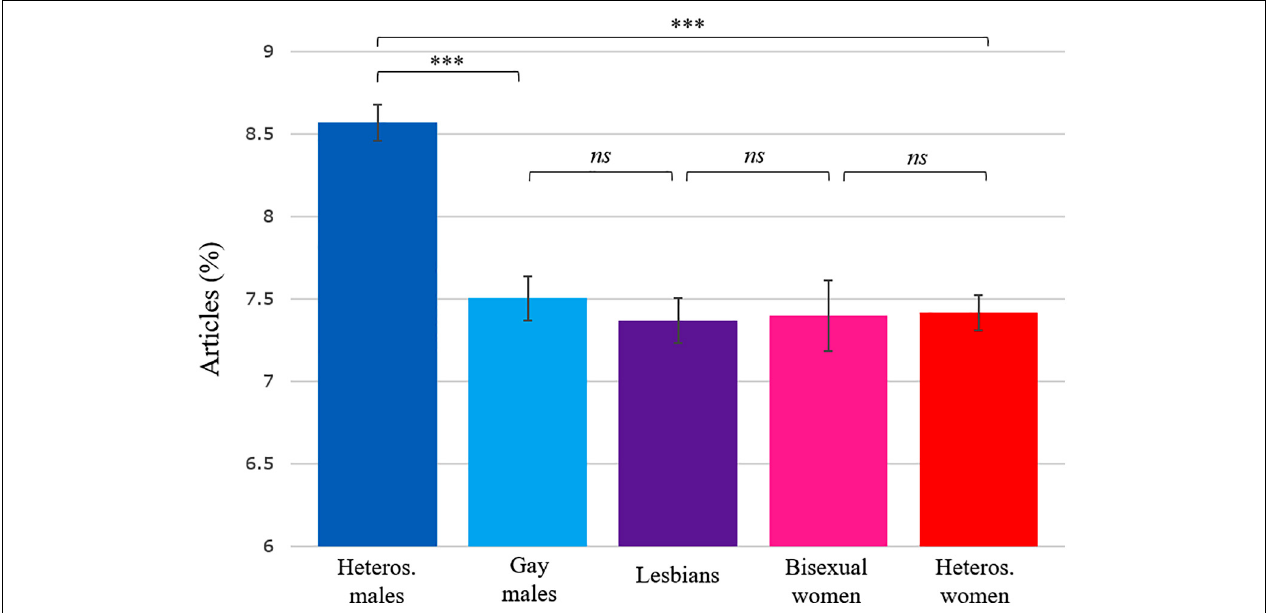
FIGURE 4 | Estimated marginal means and standard errors for article frequency in each group of authors. The estimated marginal means are adjusted for differences in publication year and author’s age at publication. ∗∗∗ p < 0.001. ns , non-significant.